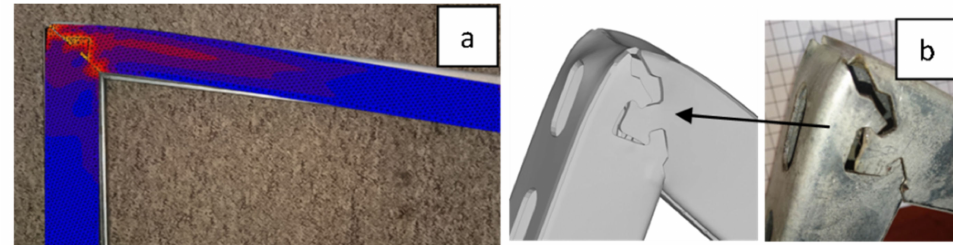
Figure 12. Comparison of simulation results and laboratory test loads of the selected prototype of the console: console deflection ( a ); deformation of the lock ( b ).